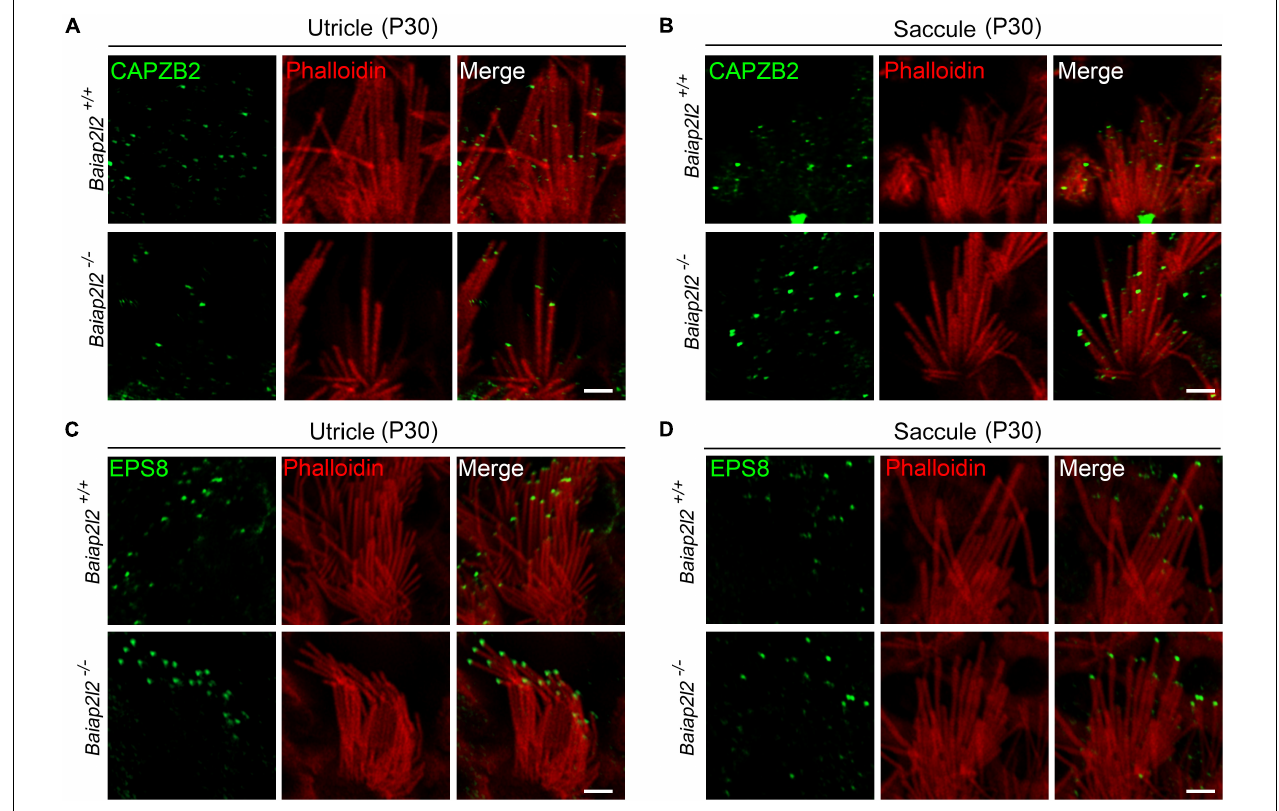
FIGURE 4 | Stereociliary tip localization of CAPZB2 and EPS8 is unaffected in VHCs of Baiap2l2 knockout mice. Whole-mount immunostaining and confocal microscopy were performed to examine the localization of CAPZB2 in utricular (A) and saccular (B) hair cells of P30 Baiap2l2 + / + or Baiap2l2 − / − mice. Similar experiments were performed to examine the localization of EPS8 in utricular (C) and saccular (D) hair cells of P30 Baiap2l2 + / + or Baiap2l2 − / − mice. TRITC-conjugated phalloidin was used to visualize stereociliary F-actin core. Scale bars, 2 µ m.